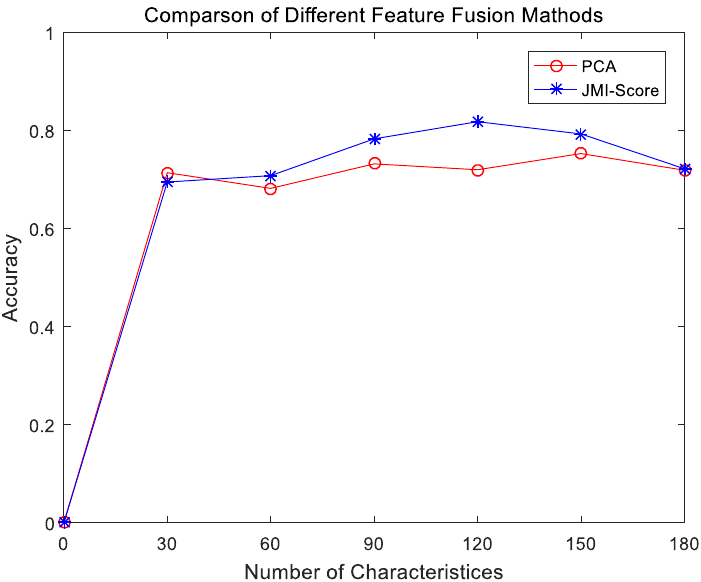
Figure 3. Feature layer fusion recognition accuracy of different feature dimensions.